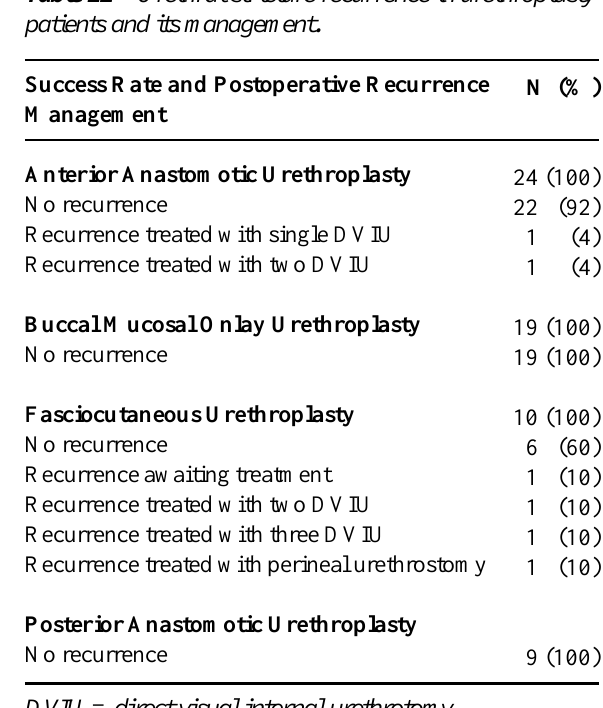
Table 12 – Urethral stricture recurrence in urethroplasty patients and its